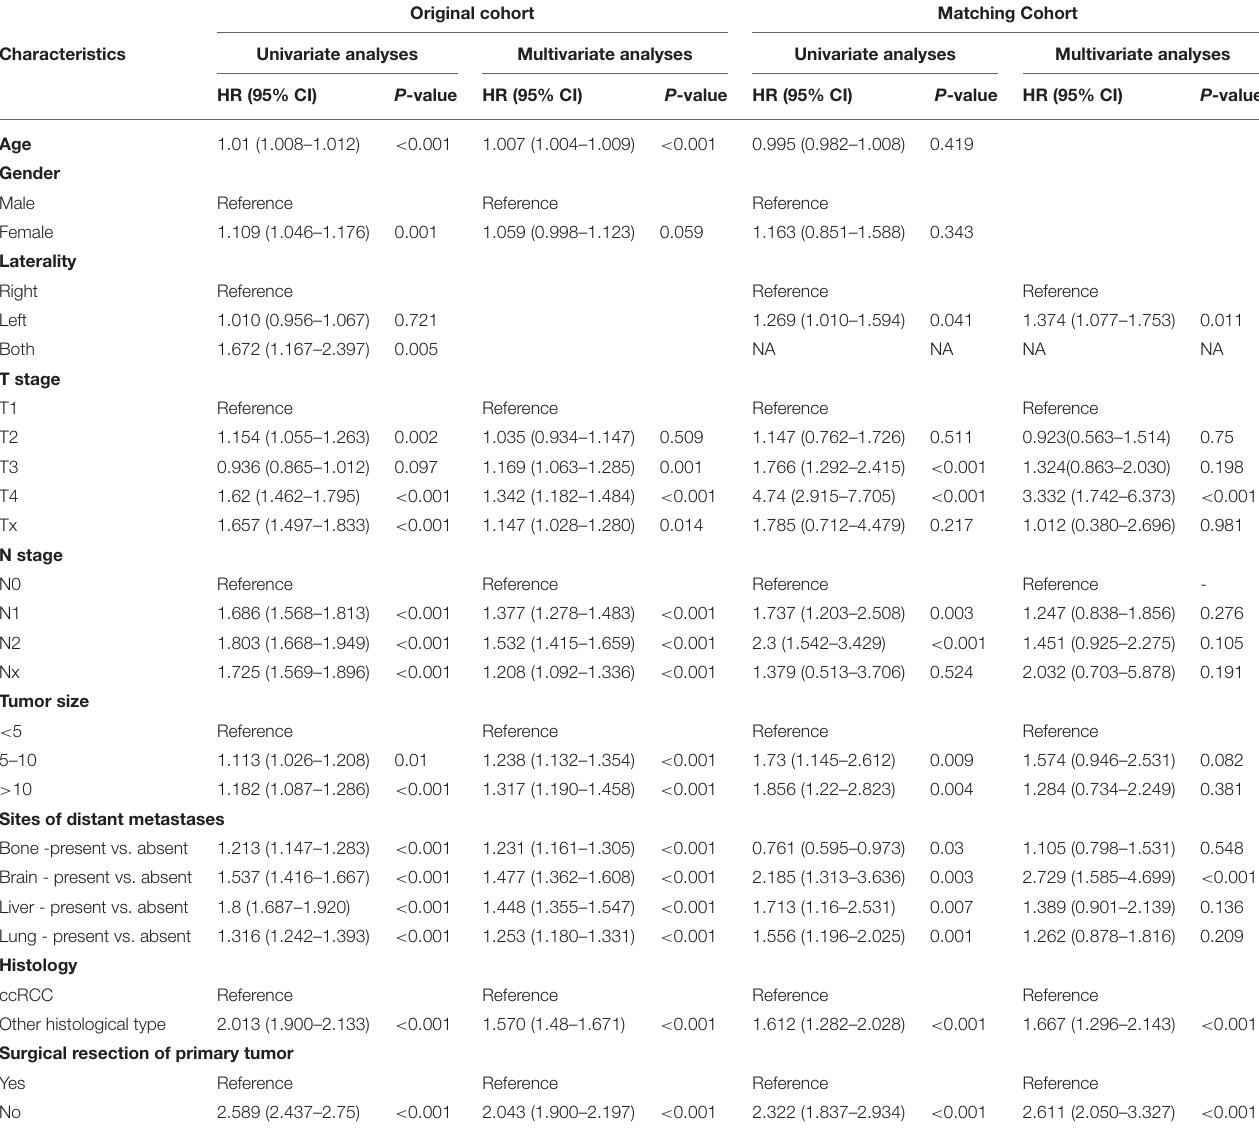
TABLE 4 | Univariate and multivariate analysis of prognostic factors influencing cancer specific